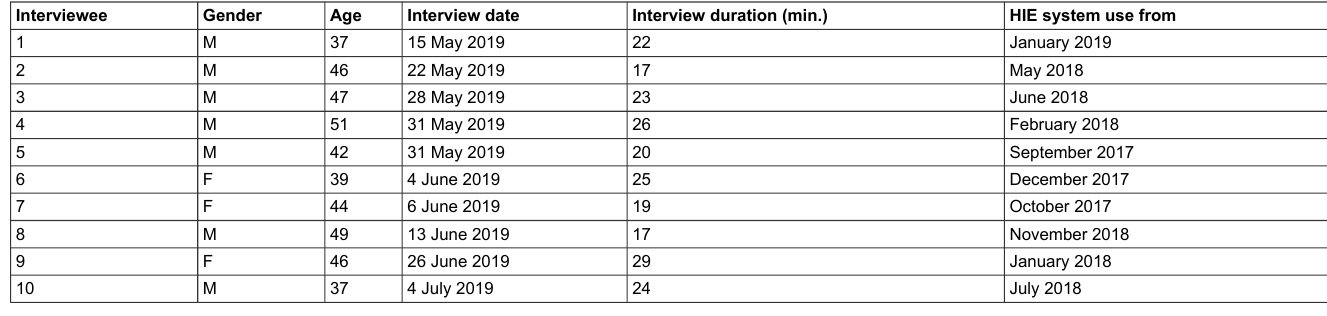
Table 2: Baseline